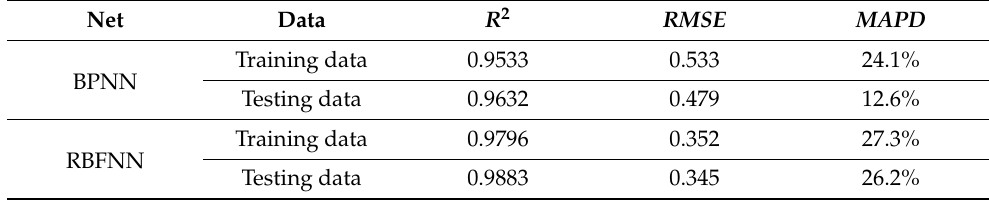
Table 2. Statistical indicators of training and testing data in BPNN and RBFNN.